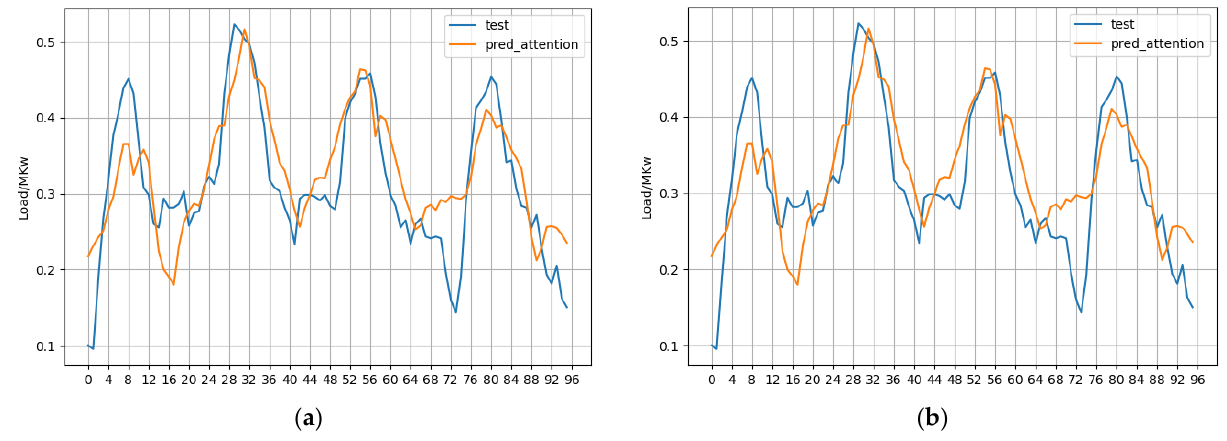
Figure 5. Comparison of prediction results for the Chinese dataset (( a ): PreAttCG; ( b ):